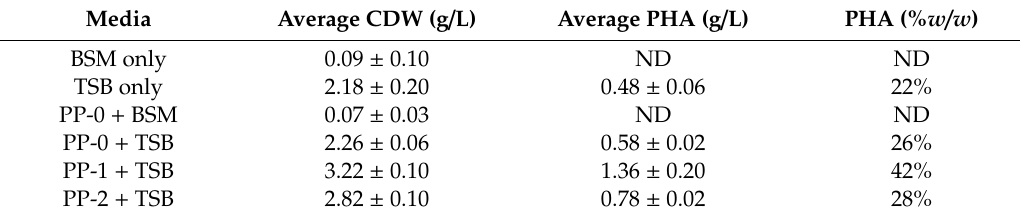
Table 3. The percentage yield of PHA synthesized by C. necator using 2 g/L PP conducted over a 48 h